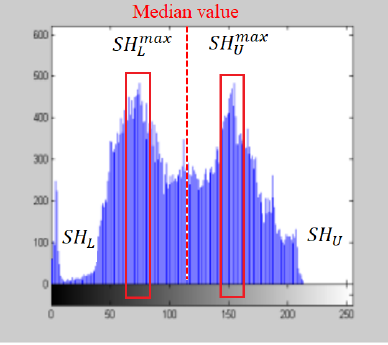
Figure 2. A chest X-ray (CXR) image histogram is divided into the two sub-histograms. SH max SH max represent the peak bin values in the lower and upper U